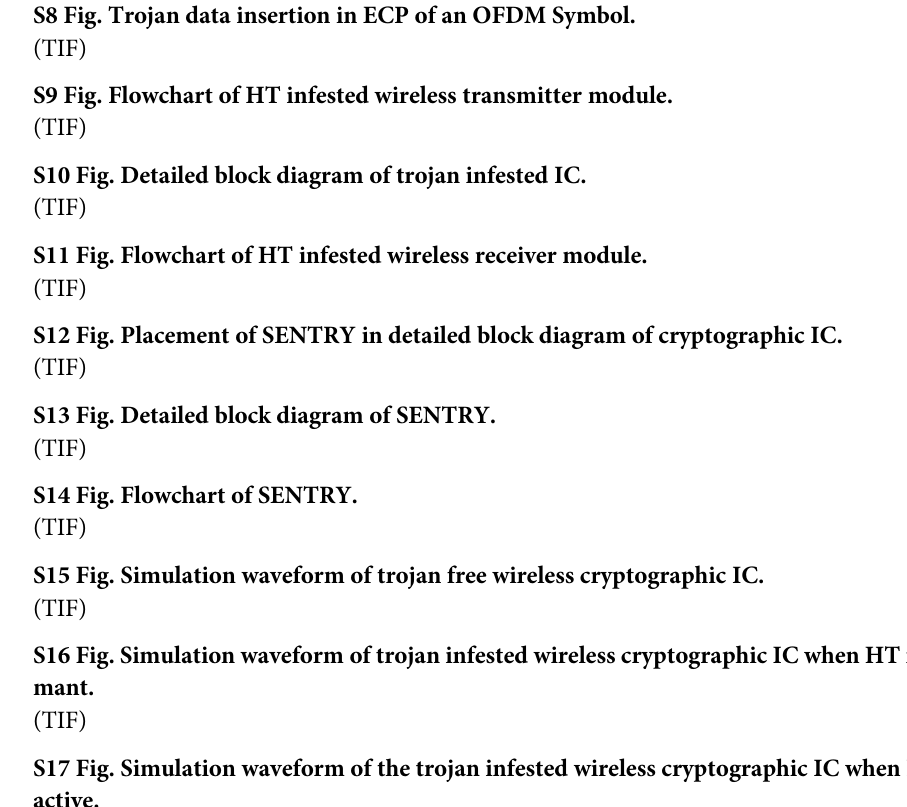
S8 Fig. Trojan data insertion in ECP of an OFDM Symbol. (TIF) S9 Fig. Flowchart of HT infested wireless transmitter module. (TIF) S10 Fig. Detailed block diagram of trojan infested IC. (TIF) S11 Fig. Flowchart of HT infested wireless receiver module. (TIF) S12 Fig. Placement of SENTRY in detailed block diagram of cryptographic IC. (TIF) S13 Fig. Detailed block diagram of SENTRY. (TIF) S14 Fig. Flowchart of SENTRY. (TIF) S15 Fig. Simulation waveform of trojan free wireless cryptographic IC. (TIF) S16 Fig. Simulation waveform of trojan infested wireless cryptographic IC when HT is dor- mant. (TIF) S17 Fig. Simulation waveform of the trojan infested wireless cryptographic IC when HT is active. (TIF) S18 Fig. Simulation waveform of SENTRY with trojan free wireless cryptographic IC. (TIF) S19 Fig. Simulation waveform of SENTRY with trojan infested wireless crypto IC. (TIF) S1 Table. Summarized threat model for AMS IC. (PDF) S2 Table. Comparison between proposed HT threat model and existing HT threat